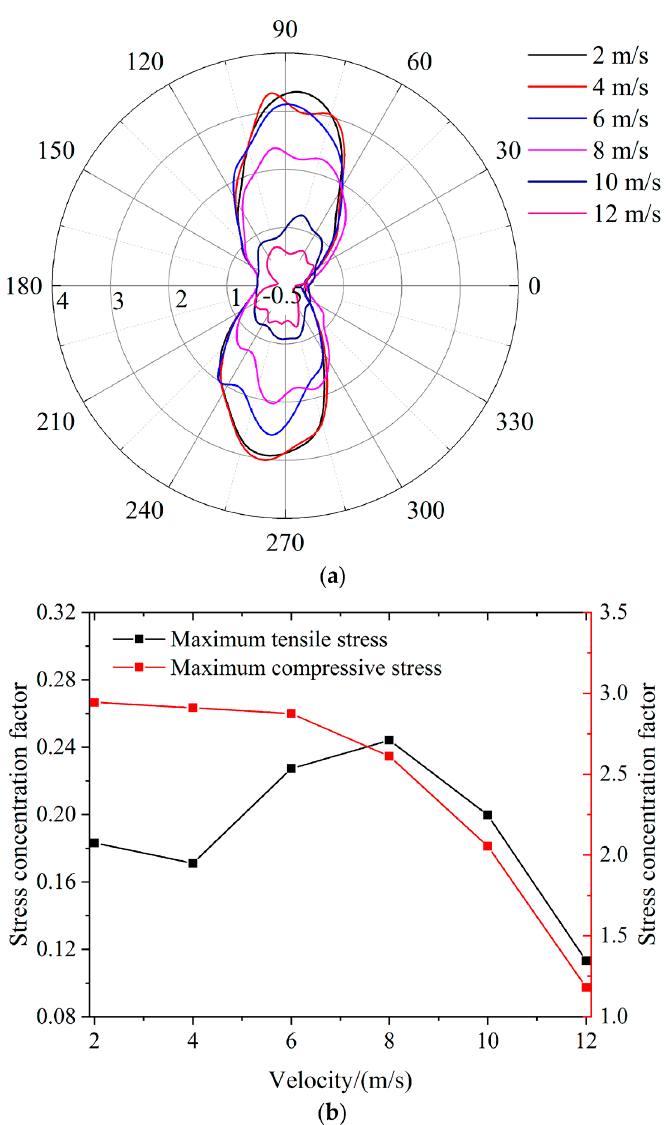
Figure 21. Variation in stress concentration factor under different amplitudes. ( a ) DSCF around the holes under different amplitudes, ( b ) maximum stress concentration factor for different